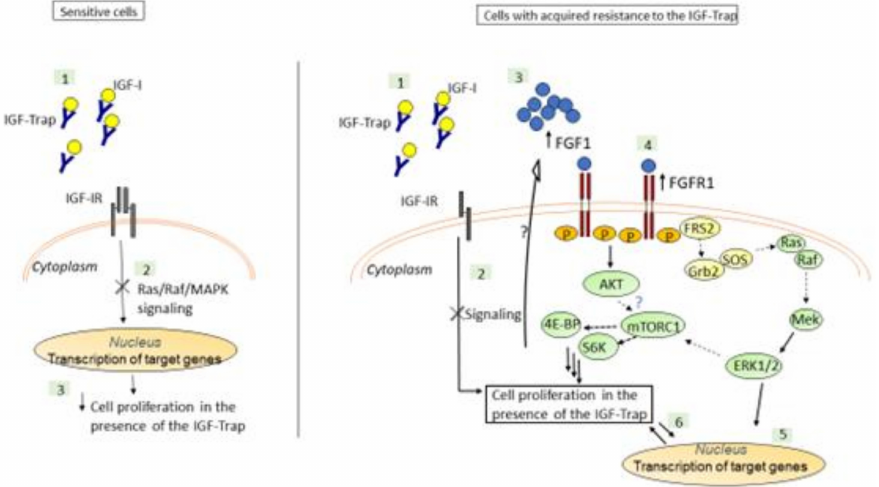
Figure 10. A postulated model for the mechanism underlying IGF-Trap resistance in MDA-MB-231. The IGF-Trap inhibits IGF-IR signaling, decreasing ERK phosphorylation and cell cycle progression and inducing apoptosis in MDA-MB-231 cells ( Left ). Our findings suggest that MDA-MB-231 cells that are continuously exposed to the IGF-Trap lose the sensitivity to the growth inhibitory effect of the Trap, due to increased autocrine FGFR1 signaling and ERK activation, mediated by increased FGFR1/FGF1 expression ( Right ). The increase in constitutive ERK phosphorylation may also contribute to increased mTORC1/S6K activation and protein synthesis in these cells, either directly or through crosstalk with the PI3K-AKT pathway [36]. Please note that postulated interactions are indicated by dotted arrows, while interactions elucidated by our data are indicated by solid